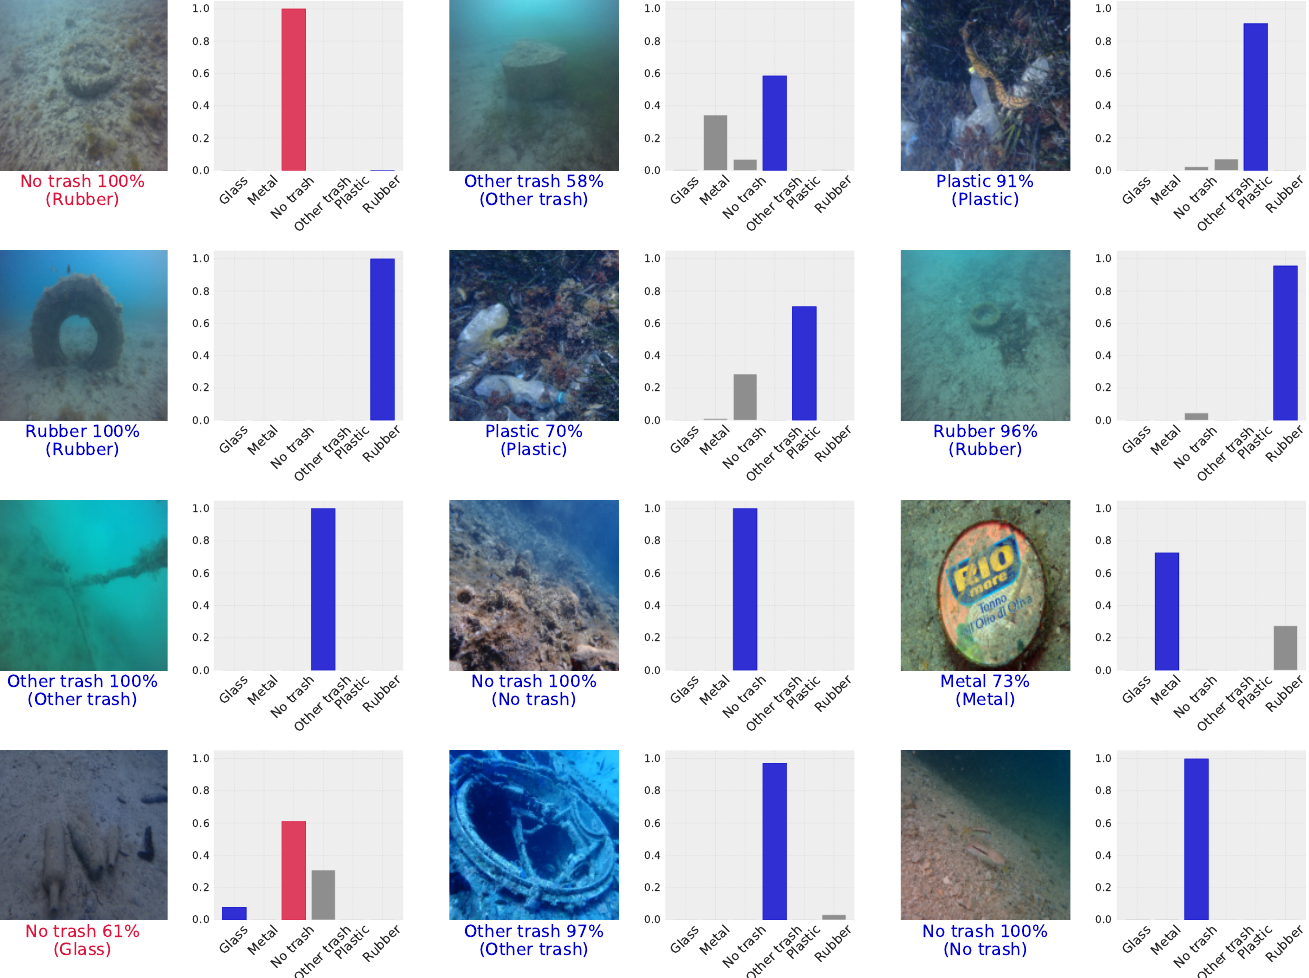
Figure 19. Predictions on new images from the realistic marine environment of the Adriatic Sea. Misprediction of the first and fourth image in the first column can be attributed to the coverage of waste objects with the seabed, making it difficult to distinguish the litter from the seafloor. Moreover, we can notice how the network associates a round shape with the Rubber class, e.g., although it correctly classifies metal can in the class Metal , it has assigned a certain probability to the class Rubber , making it the second